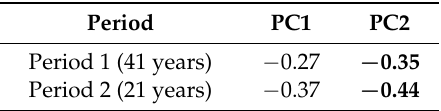
Table 2. Temporal correlation of CA Dec–Feb averaged precipitation with PC1 and with PC2 for Period 1 and Period 2. Numbers in bold are statistically significant at the 95% confidence